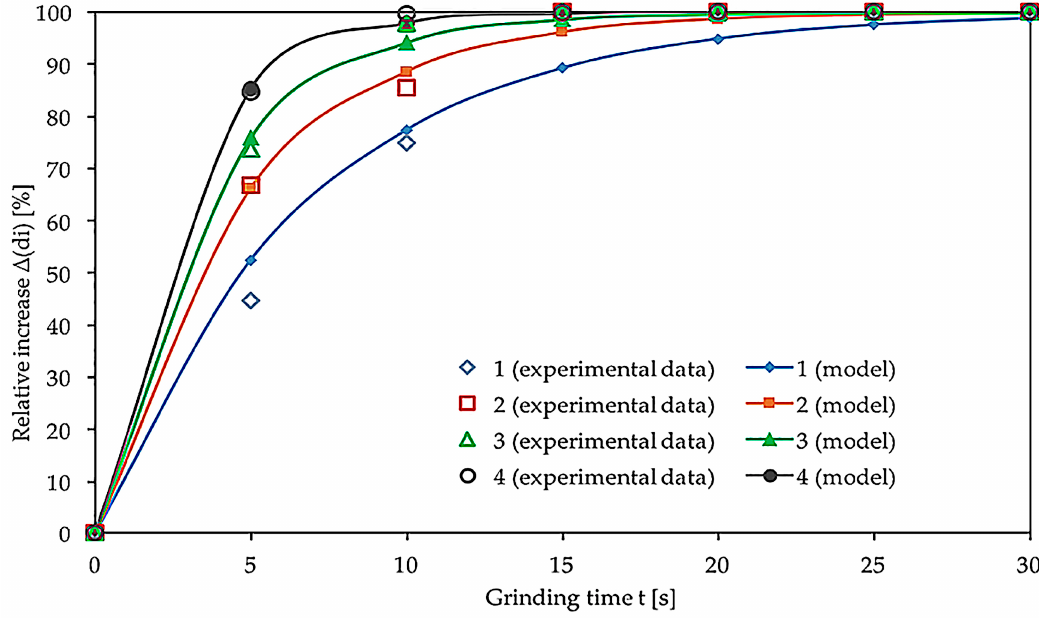
Figure 7. Curves of the relative increment of the 0–0.2 mm particle size fraction in the comminution product for the investigated grinding media characteristics.